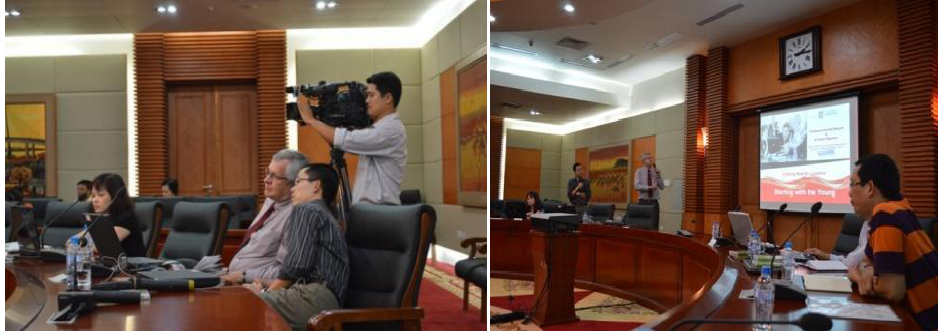
Figure 4. Professor Bosch and Dr. Nguyen launching Ecopolicy in Haiphong.